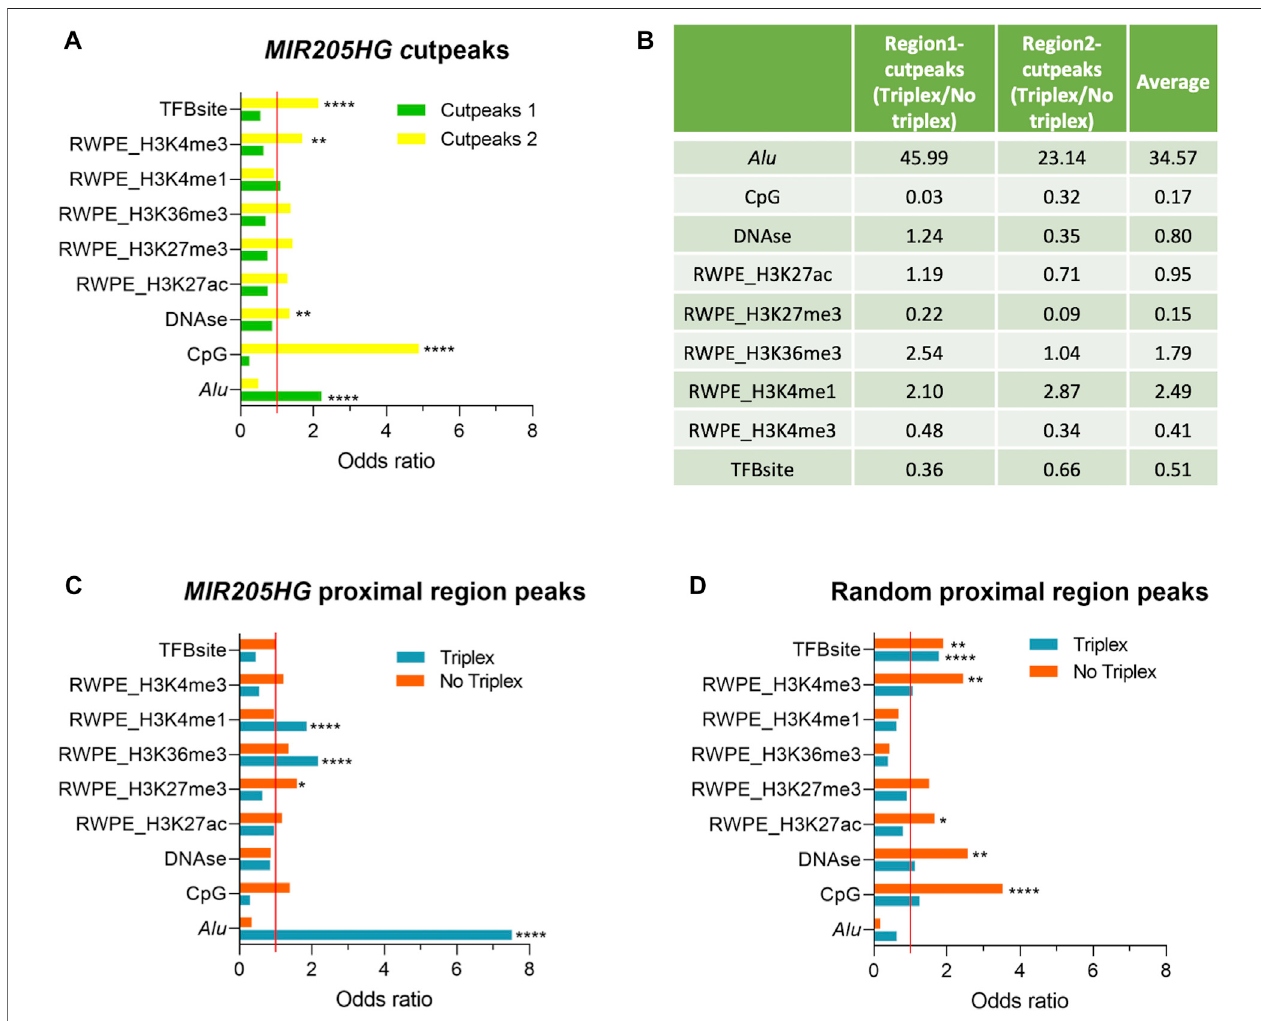
FIGURE3| Enrichmentof Alu andspeci fi chistonemodi fi cationsin MIR205HG proximalregionpeaks. (A) Thebarplotshowstheoddsratiosforthe “ region1 ” -and “ region2 ” -cutpeaksforeachLOLAlibrary.Linesetto1representsnoenrichmentascomparedtothebackground. (B) ForeachLOLAlibrary,theratiooftheoddsratios in triplex-containing and in triplex-less peaks among “ region 1 ” and “ region 2 ” -cutpeaks, together with their average, are reported to show the relative enrichment in presenceandabsenceofthetriplex. (C) Thebarplotshowstheoddsratiosfor MIR205HG proximalregionpeaksdividedintotriplex-formingandtriplex-lesspeaks for each LOLA library. (D) The bar plot shows the odds ratios for random proximal region peaks divided into triplex-forming and triplex-less peaks for each LOLA library. The computed p -Value is reported (* p < 0.05, ** p < 0.01, *** p < 0.001, **** p < 0.0001). Bar plots and the table were generated using GraphPad Prism and Microsoft Excel,